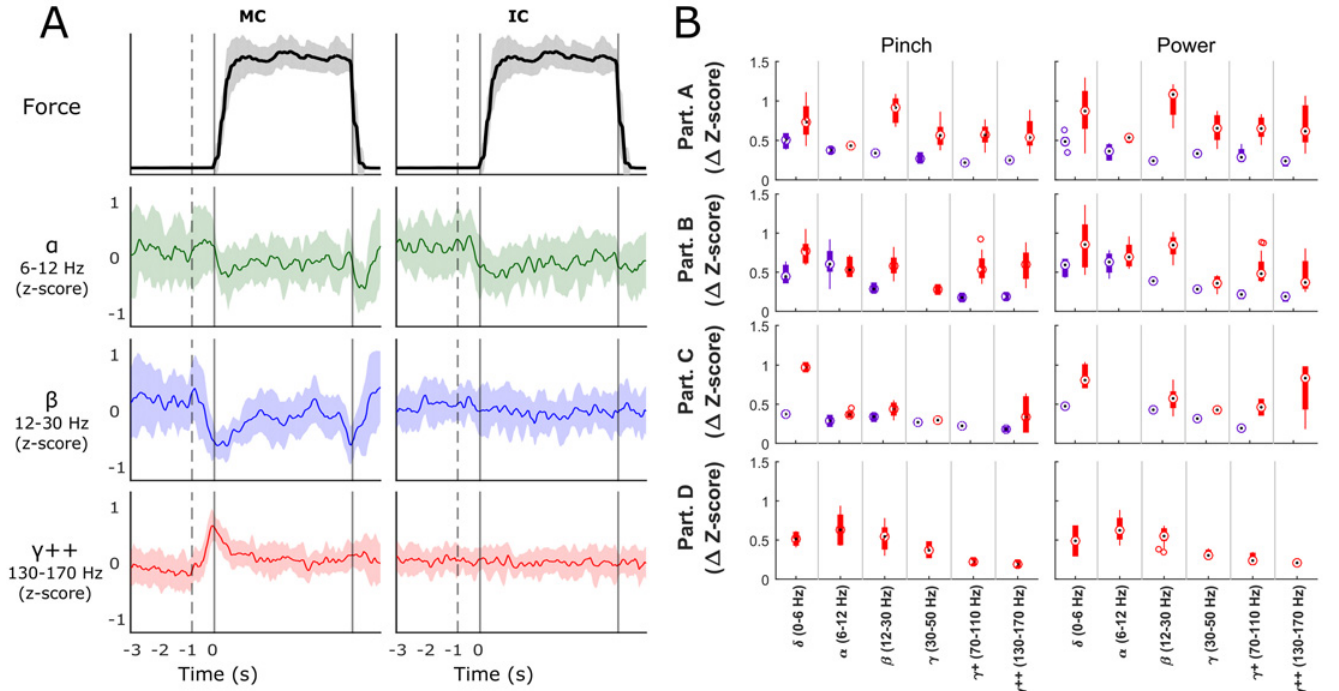
Fig 3. Signal Modulation during Force. Panel A shows average z-score modulation over time on one motor cortex (MC) channel and one insular cortex (IC) channel in the alpha, beta and highest gamma features during hard force tasks. The solid vertical line corresponds to force onset with the dotted vertical representing the average target cue time. Shaded regions indicate confidence intervals for the signal means of each frequency band. Panel B shows the mean ± standard deviation depth of modulation (change in z-score from baseline) for statistically significant MC (red bars) and IC (purple bars) channels, organized by participant (rows) and by frequency band (x-axis) for each of the two grasping configurations. All participants showed significant modulation in the both motor and insular cortices (excluding D who did not have electrodes placed in the insula).